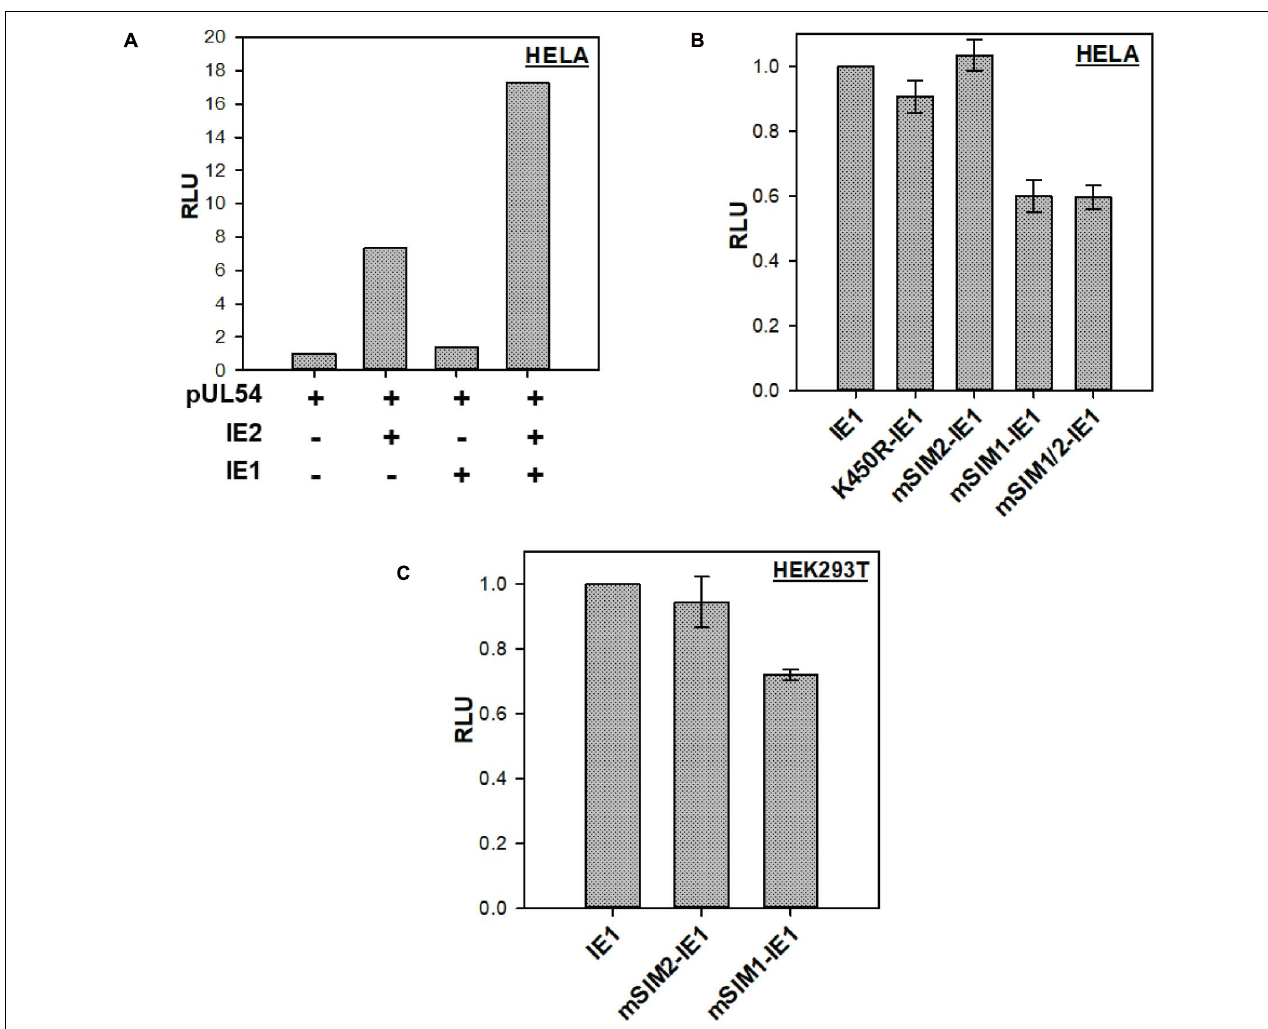
FIGURE 4 | IE1-SIMs in IE1 enhanced IE2 transactivation activity: (A) Transactivation of pUL54-Luc by IE2 in the presence or the absence of IE1. (B) IE2 and pUL54-Luc were transfected in HeLa with wt or SIM mutants of IE1, as mentioned. Luciferase activity was tested 40–48 h post-transfection. The right panel shows an expression of IE2 and IE1 mutants ( n = 3). (C) Similar to (B) but in